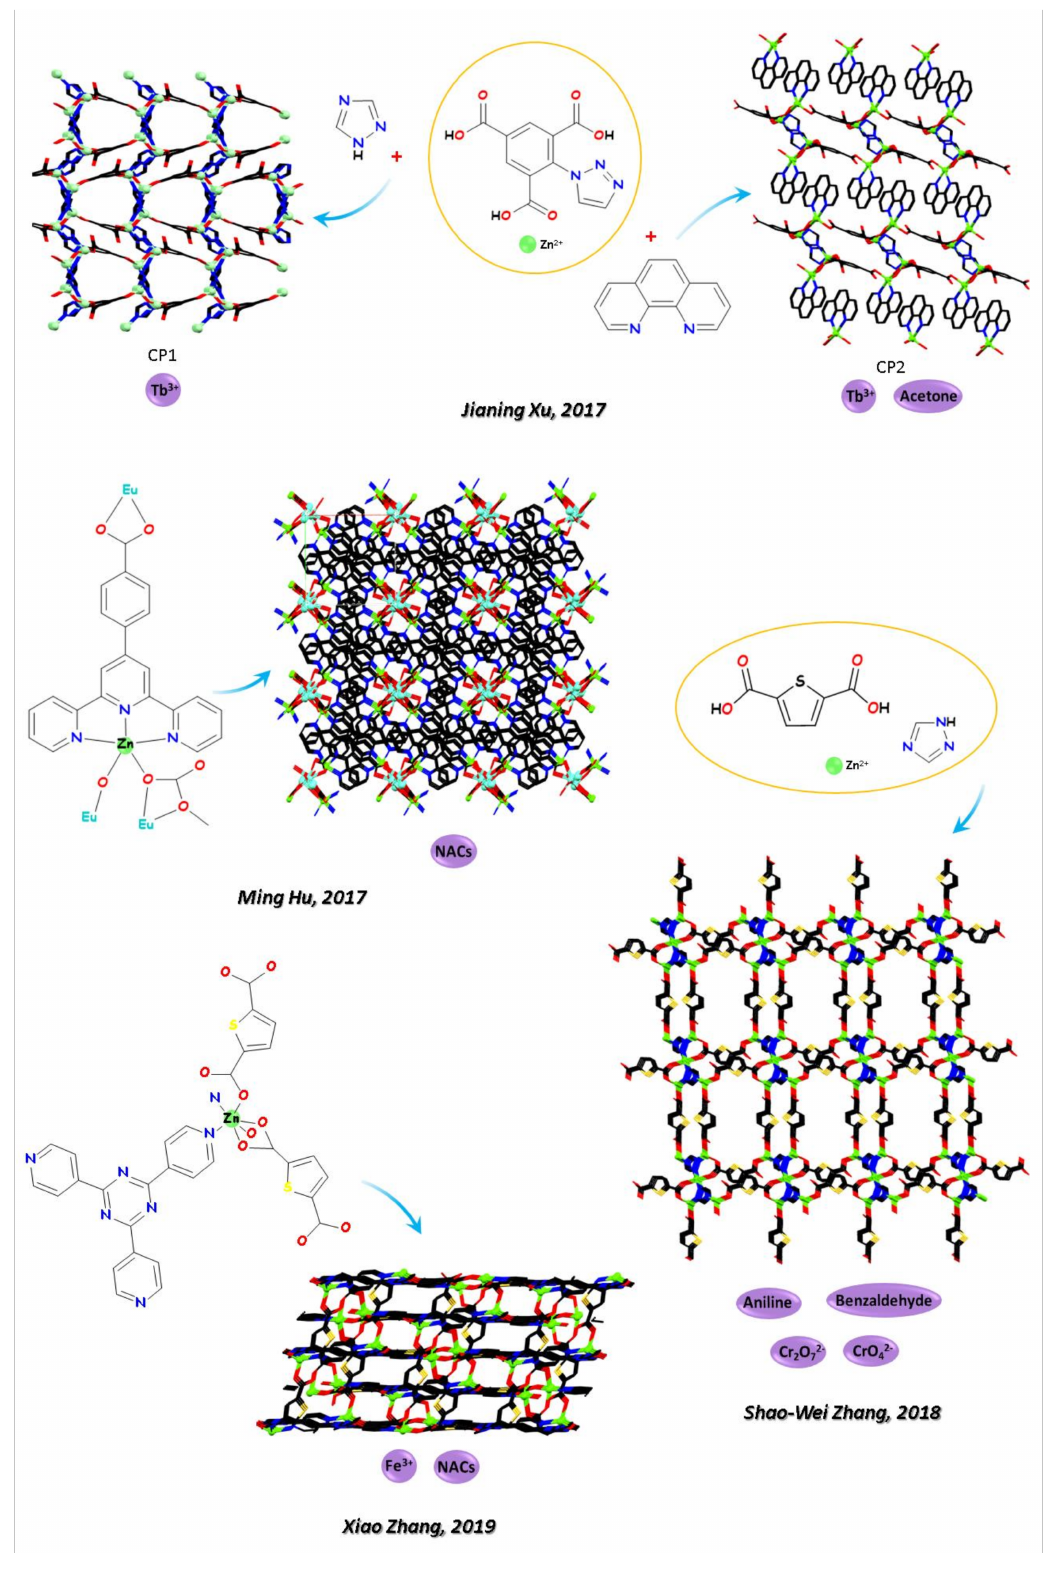
Figure 3. Other representative structures of Zn-CPs for multi-sensing of metal cations, oxyanions, and NACs metal cation sensing. Figures readapted by using Mercury software